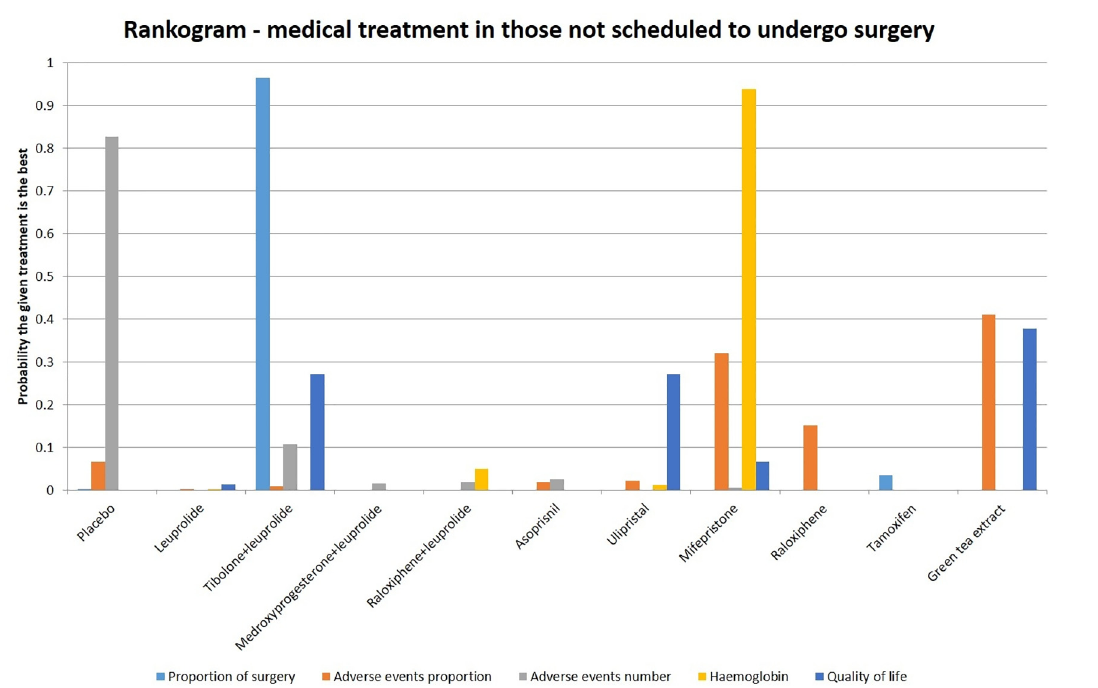
Fig 3. Different medical treatments in those not scheduled to undergo surgery —